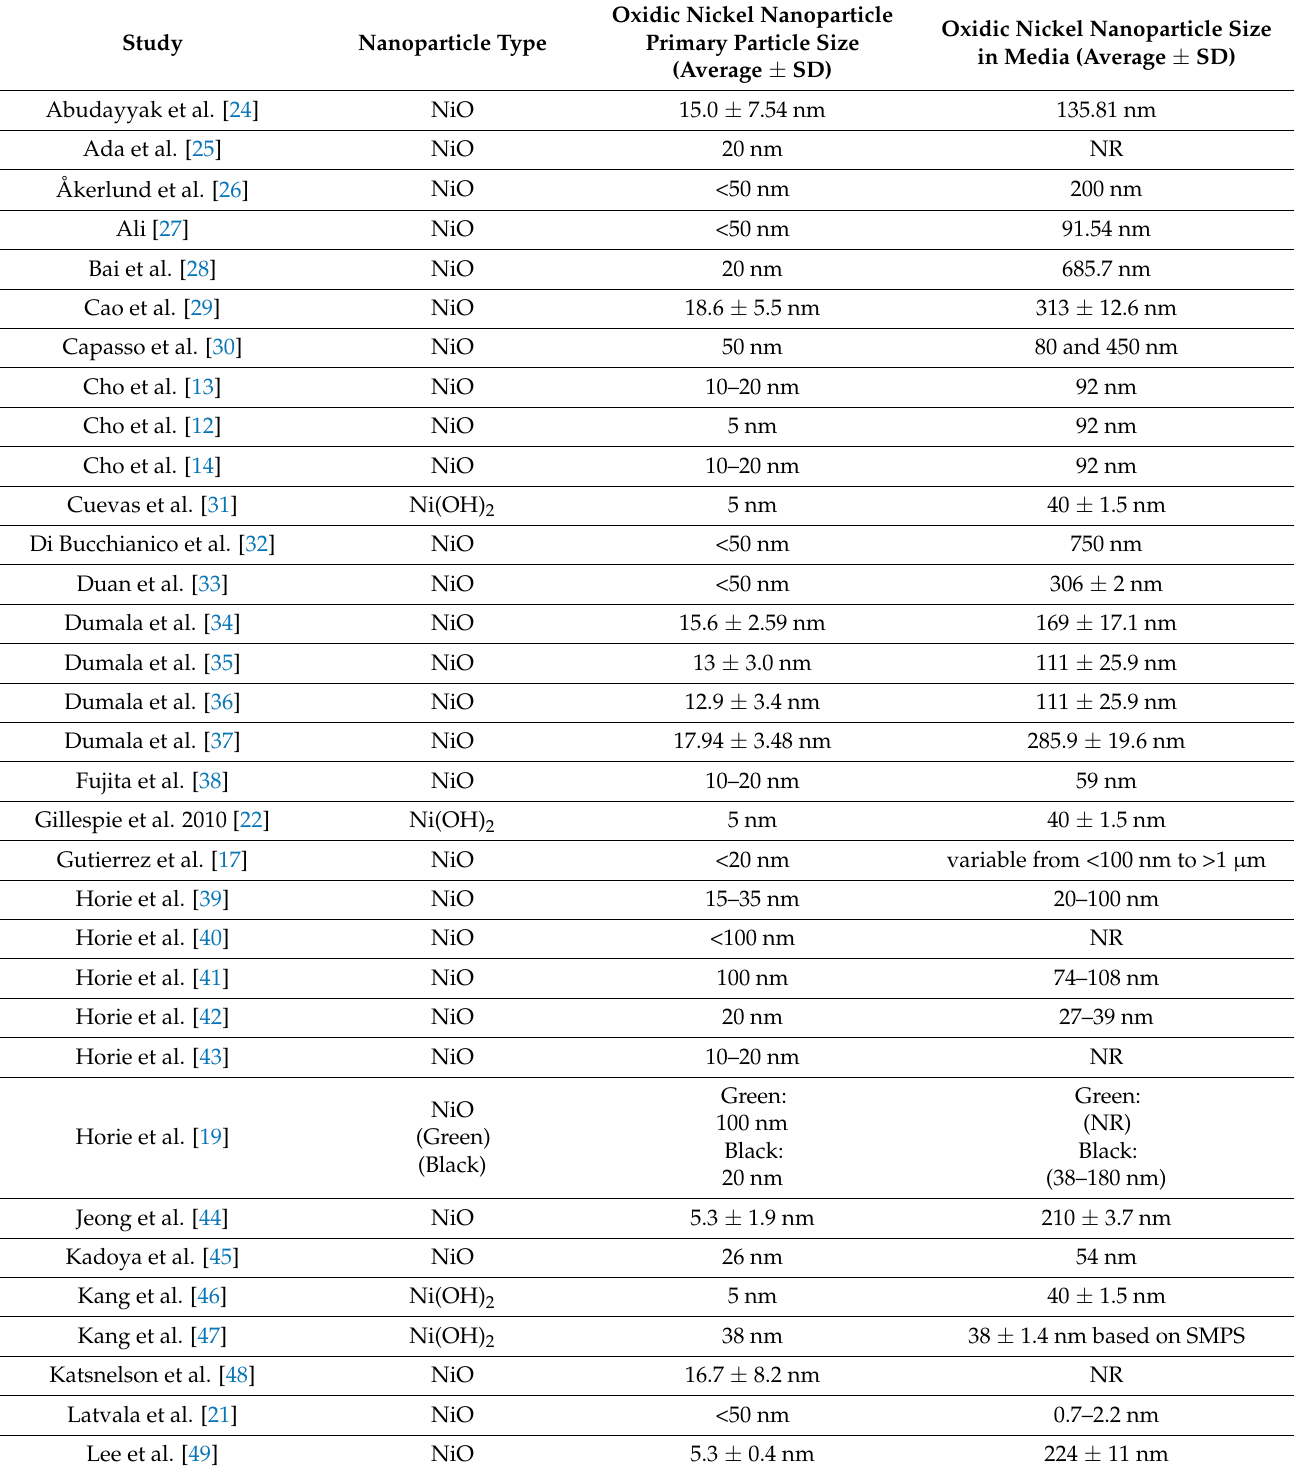
Table 1. Primary particle size and size in media of nanoparticles used in the studies investigating the toxicity of oxidic nickel